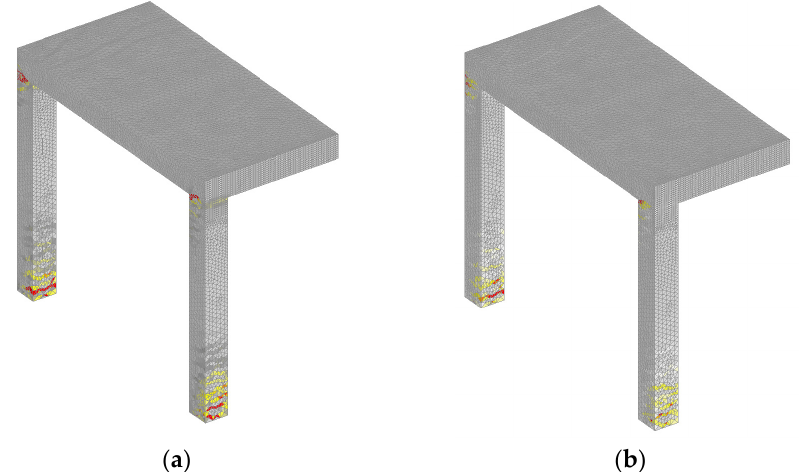
Figure 19. Crack pattern at peak load, quasi-static analysis for loading rate 1885 mm / s: ( a ) no rate sensitivity and ( b ) with rate sensitivity (red = maximum principal strain that corresponds to crack width = 1.30 mm).